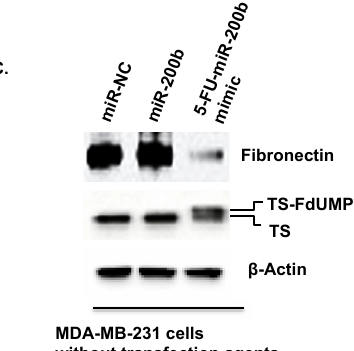
Figure 5. Delivery of 5-FU-miR-200b mimic does not require transfection reagent. miR-negative control (NC), miR-200b and 5-FU-miR-200b mimic were transfected into MDA-MB-231 cells ( A ) or MCF-7 cells ( B ) with or without oligofectamine reagent. Cell proliferation was measured by MTT assay. ( C ) Whole cell lysate from MDA-MB-231 cells transfected with the indicated miRNAs without oligofectamine reagent were analyzed by western blot assay with antibodies against fibronectin, TS-FdUMP and β -actin. Representative images were carried out at least three times.